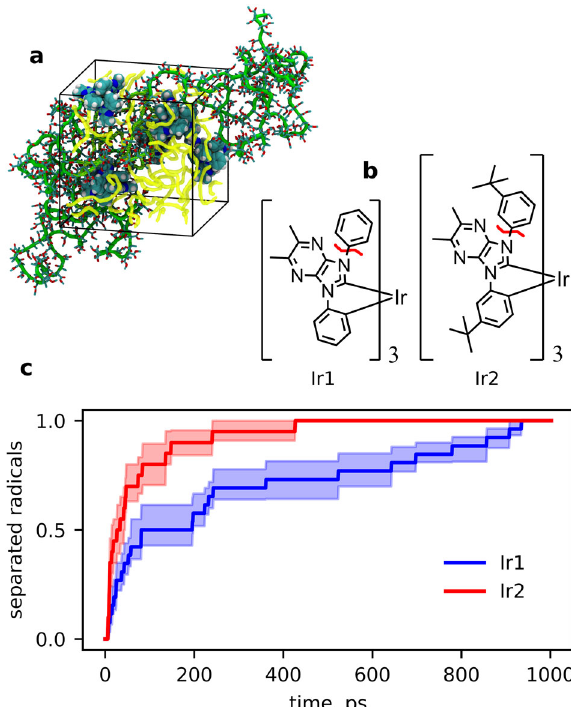
Fig. 2 Simulations of doped PMMA-based materials. a Equili- brated simulation box. The chain of PMMA (highlighted with green) spans over several periodic boxes. Being wrapped inside the reference box, it constitutes the morphology of the bulk material (shown with yellow without atomistic details). Light-emitting molecules are represented with atomic Van der Waals spheres. b Structures of the Ir(III)-based dopants. c Portion of the separated products after homolytic bond cleavage as a function of time. Filled areas denote standard error